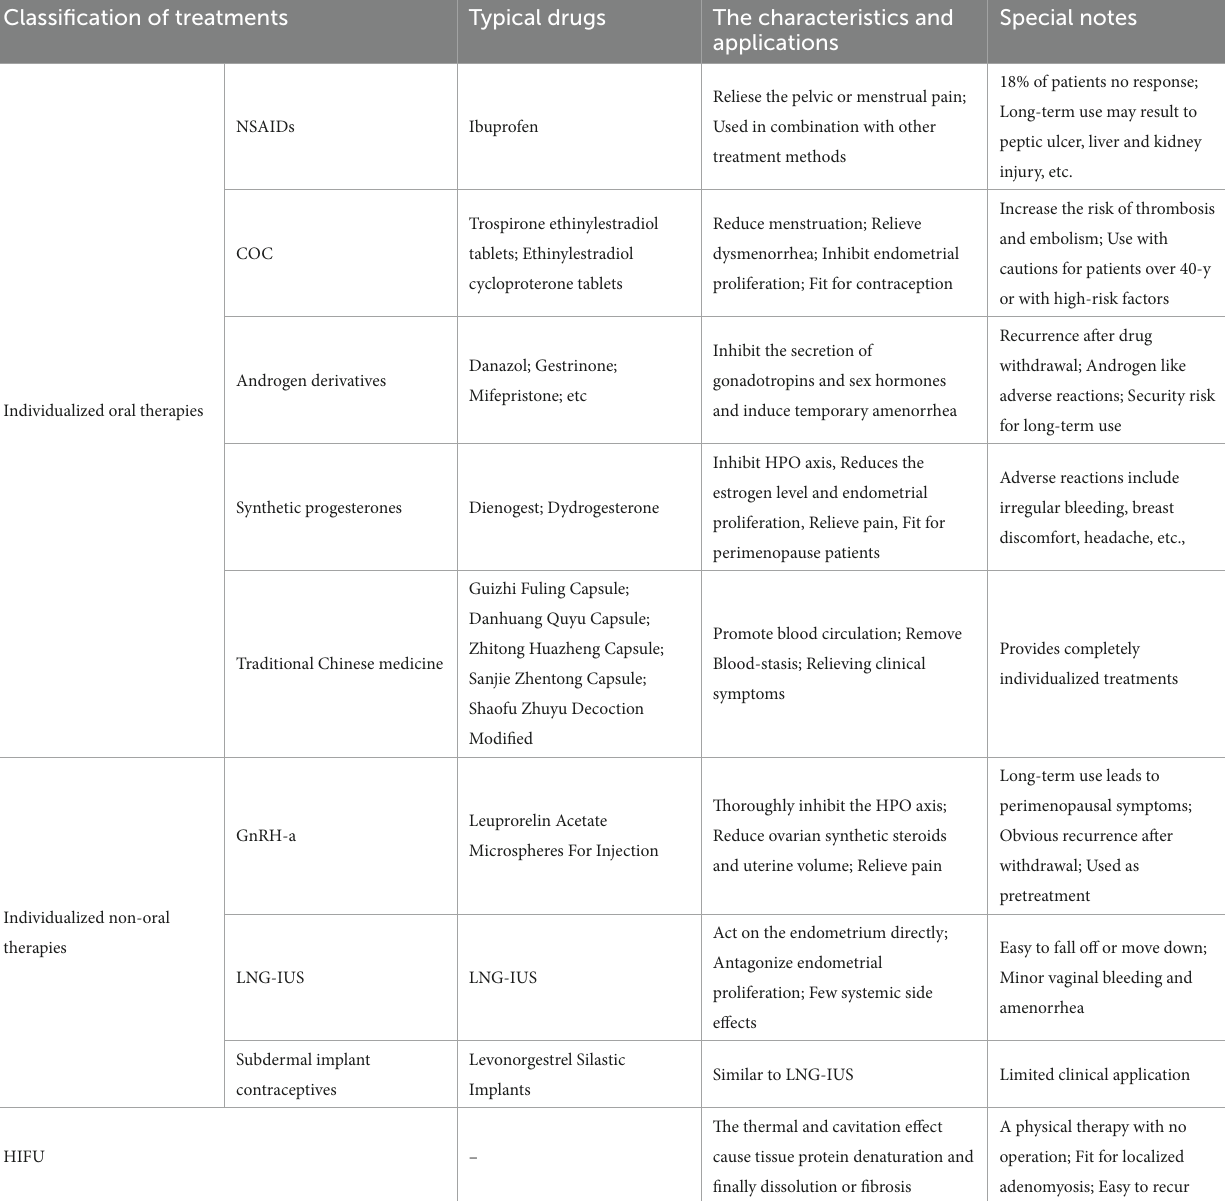
TABLE 1 The characteristics and application of individualized fertility preserving treatments for adenomyosis. Classification of